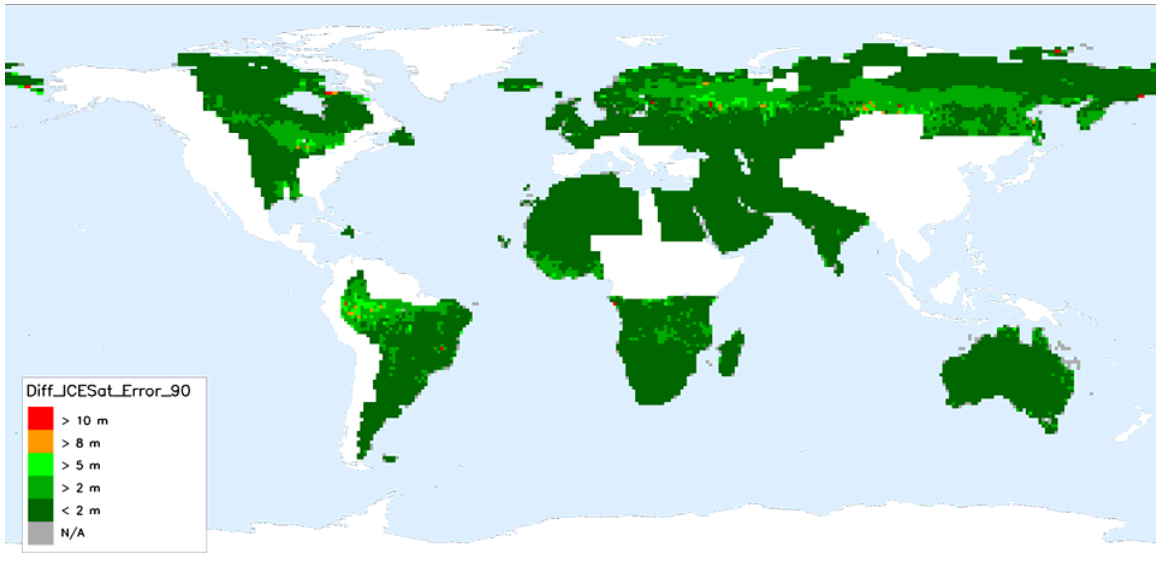
Figure 7. Global map showing 90% absolute height accuracy per DEM tile in meters (status February